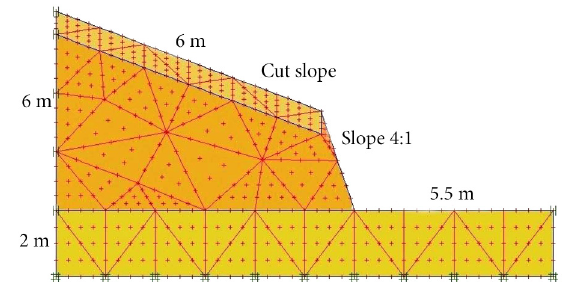
Figure 2. Geometric simulated model for cutslope and fillslope in forest roads